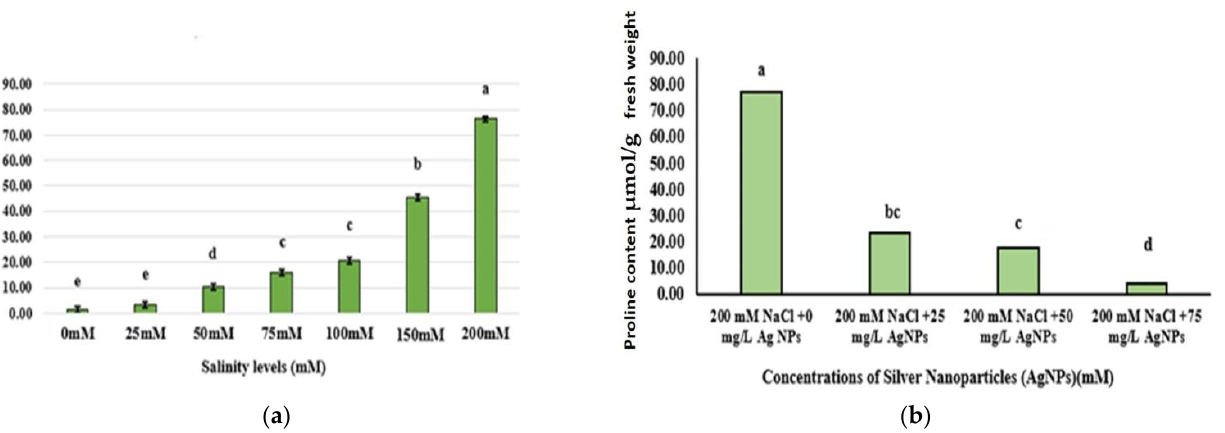
Figure 3. Proline content (µmol/g FW) of the Q6 quinoa plantlets. ( a ) Effect of different NaCl levels on proline content (µmol/g FW) of Q6 quinoa plantlets; ( b ) effect of adding different levels of Ag NPs on protein content of Q6 quinoa plantlets grown under the highest NaCl level (200 mM). Data are the means ± SE of three replicates. Different letters within the columns indicate the means that have a significant difference at the p ≤ 0.05 probability levels. Vertical bars represent the standard error at the p ≤ 0.05 probability levels.